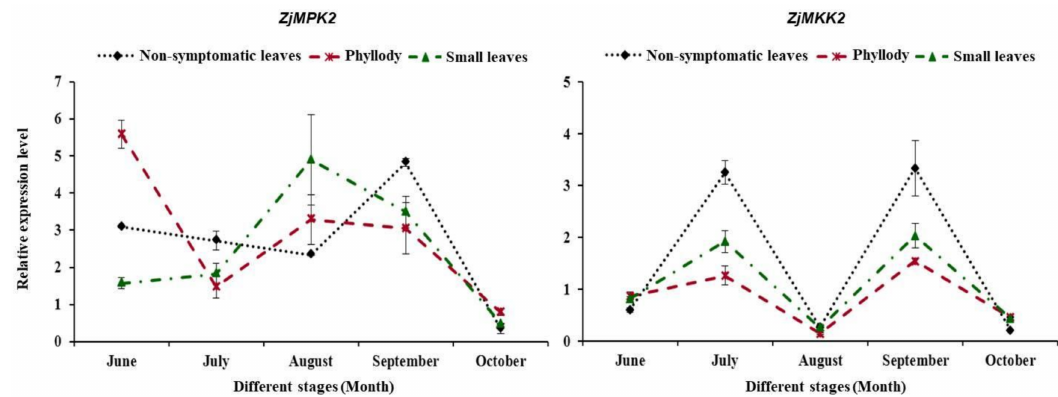
Figure 3. The expression trends of ZjMPK2 and ZjMKK2 genes in tissues showing di ff erent JWB disease symptoms. ZjACT was used as the internal standard. The leaves from healthy trees were used as control. The mean expression value was calculated from 3 independent replicates. The vertical bars indicate the standard